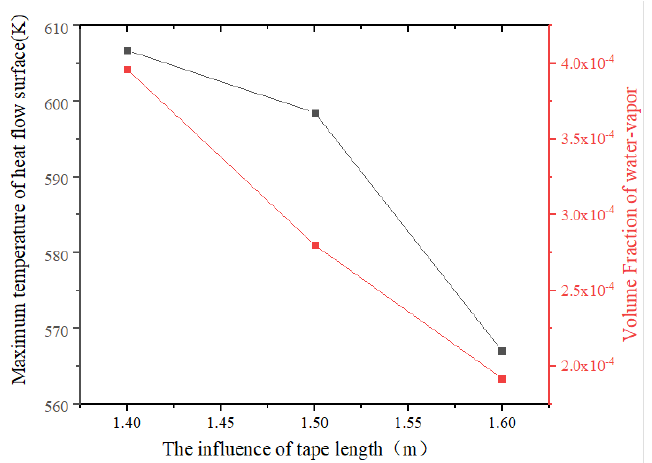
Figure 12. Maximum temperature and maximum bubble volume fraction under different tape lengths.